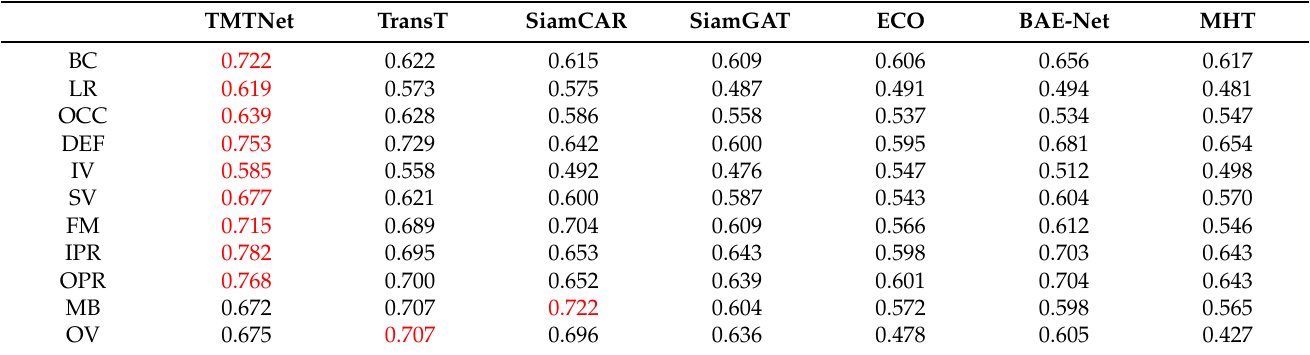
Table 3. The AUC score of 7 trackers in eleven challenging scenarios. The best result is labeled in